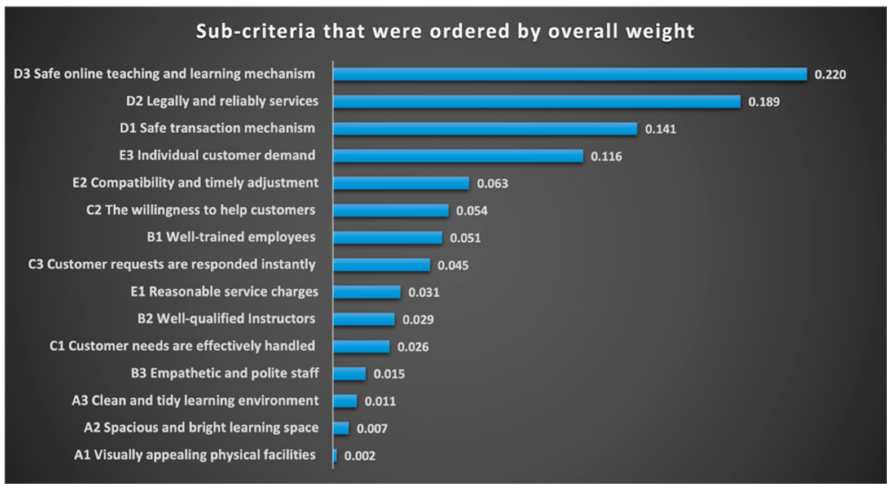
Figure 6. The overall weight and ranking of